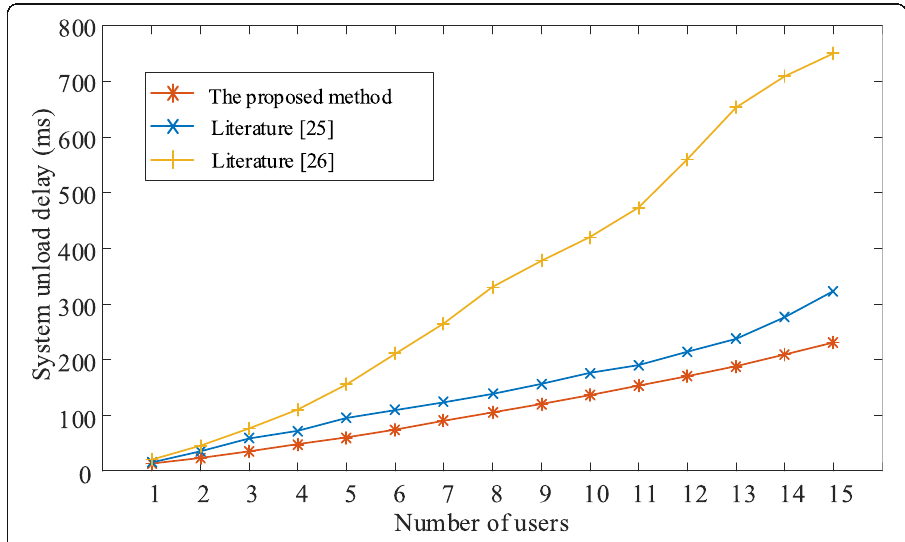
Fig. 6 Relationship between total delay and number of